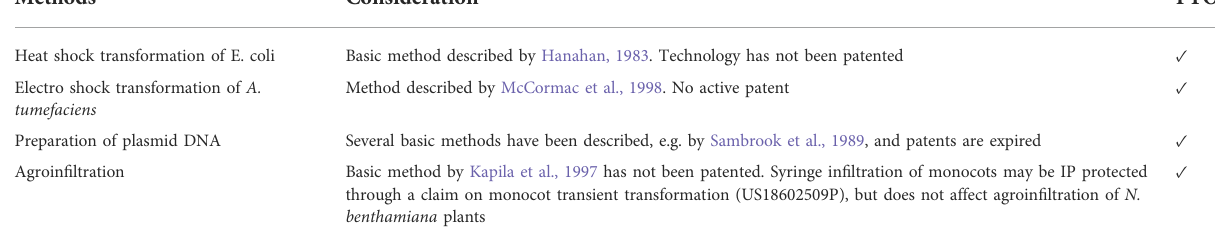
TABLE 2 FTO analysis on methods involved in the ATT technology.